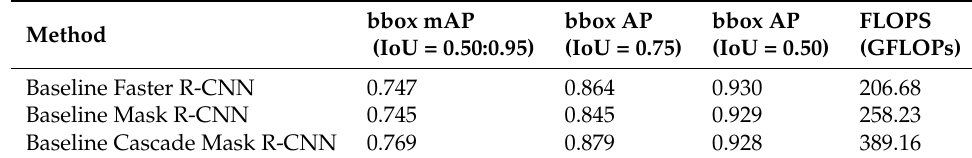
Table 6. The established baseline results on the IIIT-AR-13k [9] dataset.